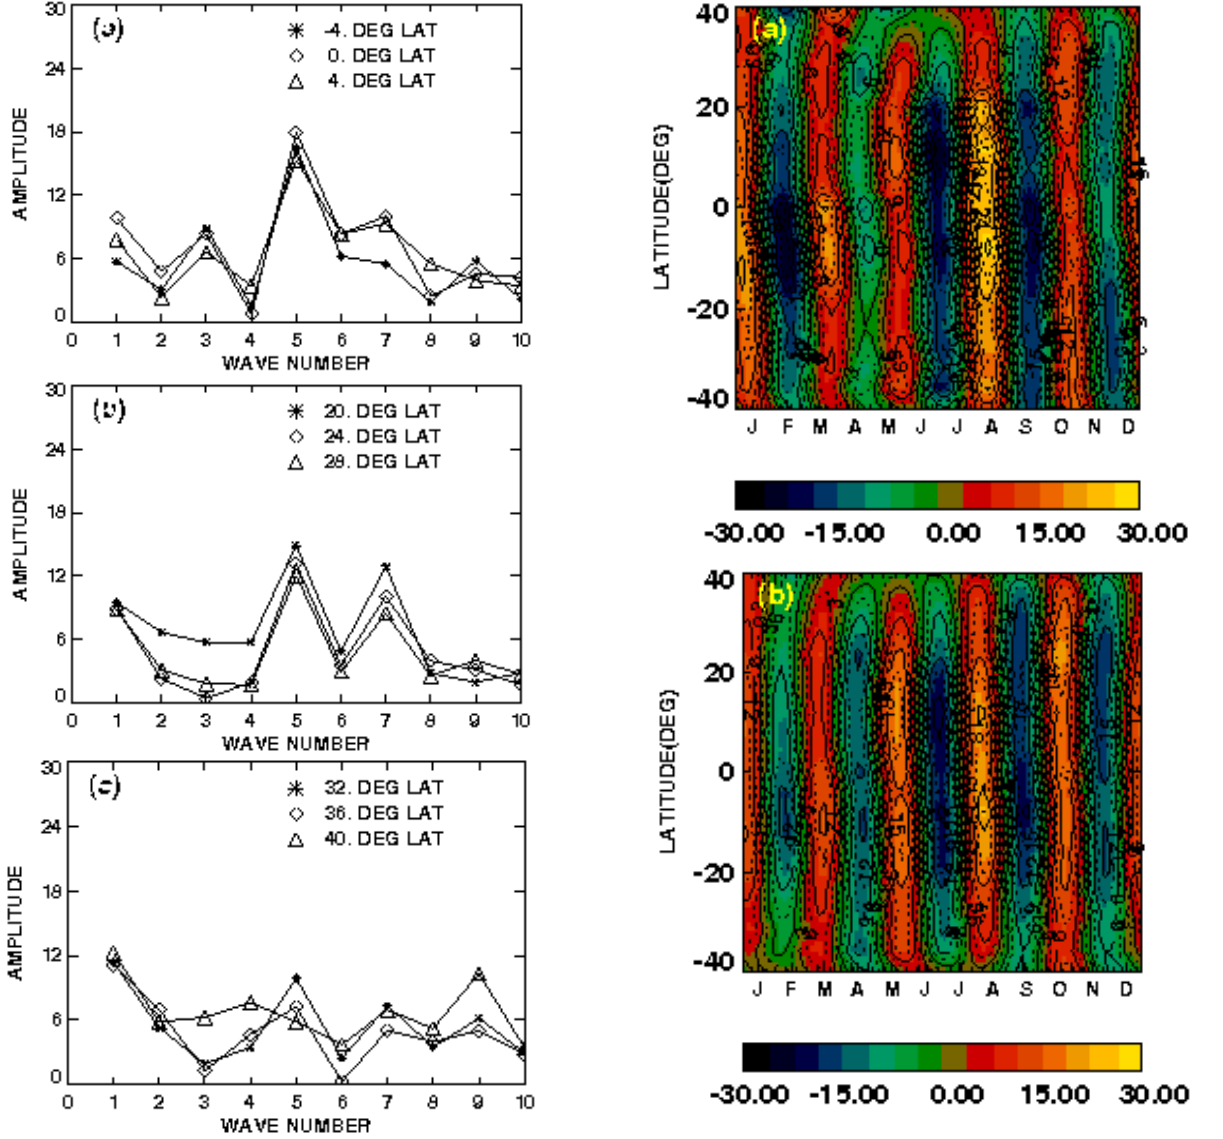
Fig. 2. Synthesized results (m/s) including only wave numbers 3, 4, 5 (4 to 2.4 month periods) based on zonal mean meridional winds from HRDI at 95km, on latitude and day-of-year coordinates: ( a ) Based on single year data (year days 92226 to 93226); ( b ) as in a), but for data from several years merged into one 365-day period. averaging of the data. Data for each day are distinct due to the differences of the local solar times at which the measure- ments are made. As noted above, the algorithm uses a least squares fit. For least squares, merging the data is equivalent to fitting the data for individual years and then averaging the coefficients for each year. Inter-annual differences are there- fore smoothed. Our separate results based on individual-year data and merged data show that the inter-annual differences are not large enough to change our conclusions.